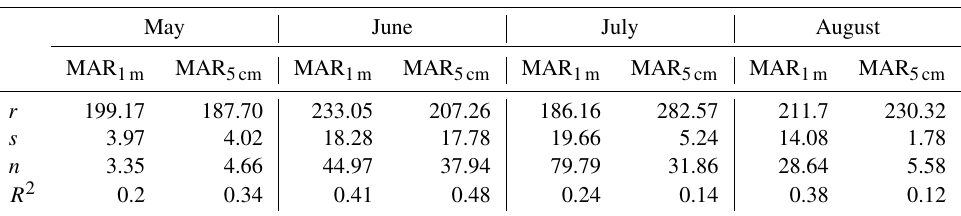
Table 7. Parameters of the spherical function fitted to the empirical semi-variogram for the maps of melt duration (MD) obtained by cumu- lating the LWC simulated by MAR over the first 1m and 5cm of the snowpack.